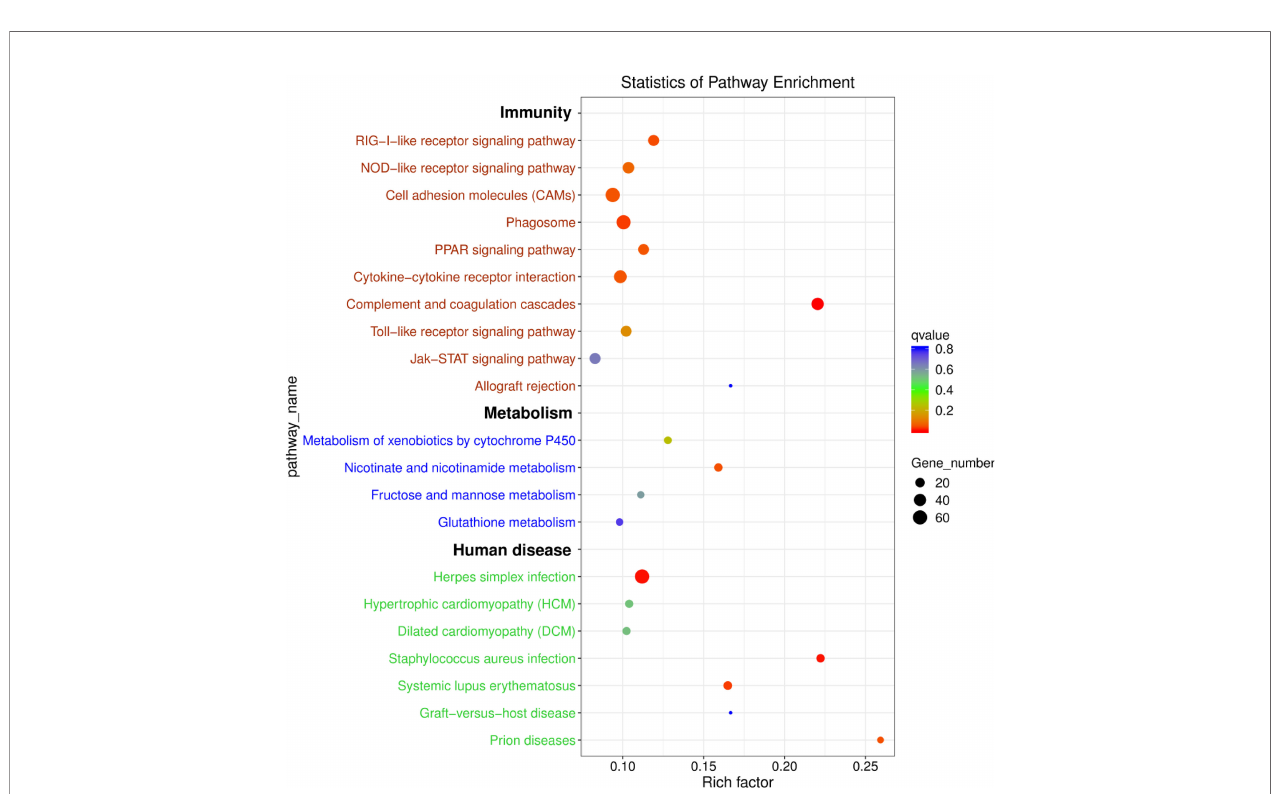
FIGURE 4 | The top 30 most signi fi cant level-3 GO terms of DEmRNAs between WR_S and YR_S groups. The x-axis represents − log2 ( q value), the y-axis represents GO_terms.